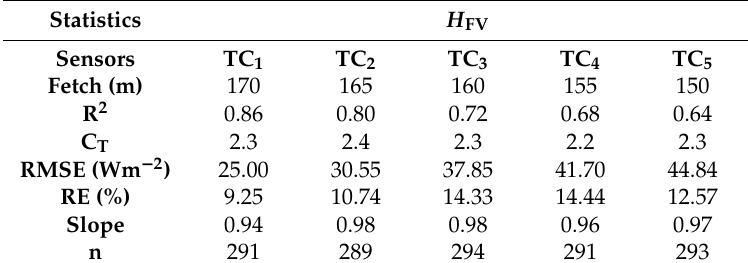
Table 4. Statistical parameters of the regressions between H EC and H FV at the di ff erent positions: R 2 , the similarity constant C T , RMSE, RE, and slope. n is the number of data points in each regression. Fetch is the distance from the field edge for the dominant wind direction.